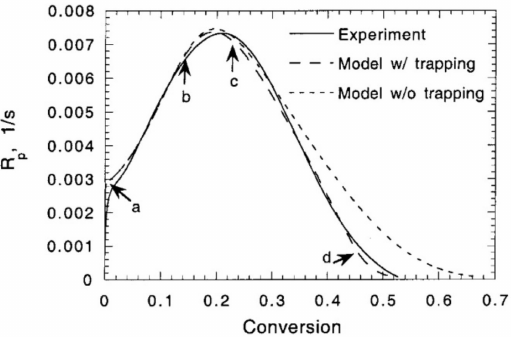
Figure 23. Predicted reaction rate (with and without radical trapping) and actual reaction rate mea- sured by photo-DSC versus conversion during the polymerization of DEGDMA with 0.42 mW cm − 2 light intensity and 0.1 wt.% DMPA. Reprinted from reference [109] with permission from the Ameri- can Chemical